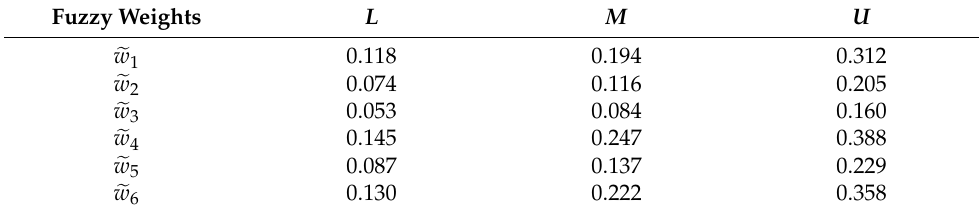
Table 4. The fuzzy preference weights of the